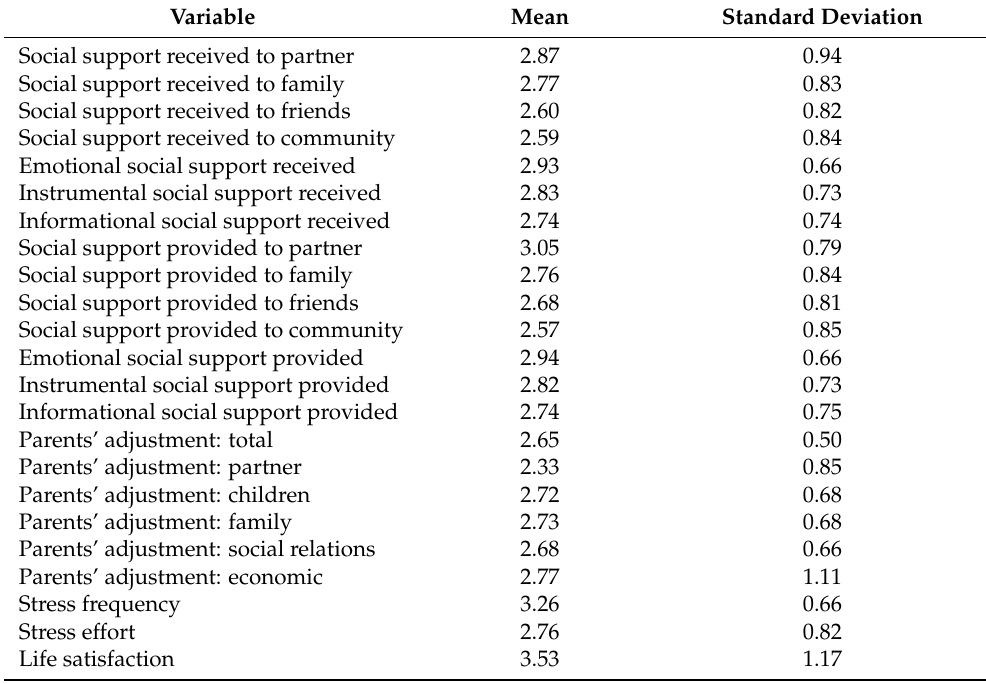
Table 2. Descriptive statistics of study variables ( N =